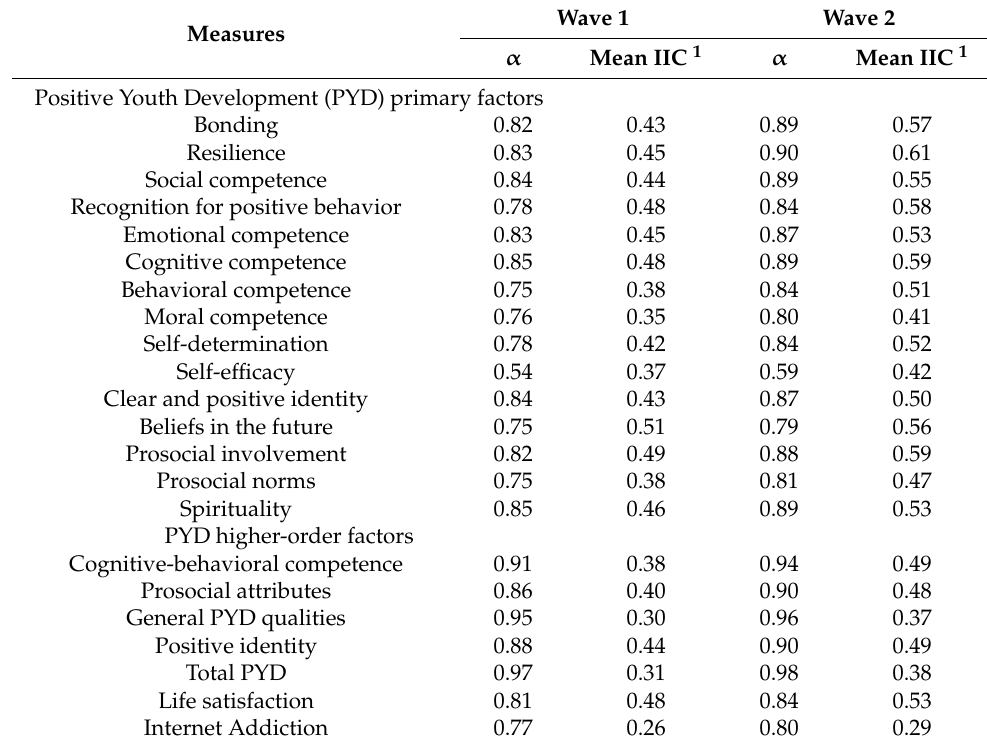
Table 1. Reliability of